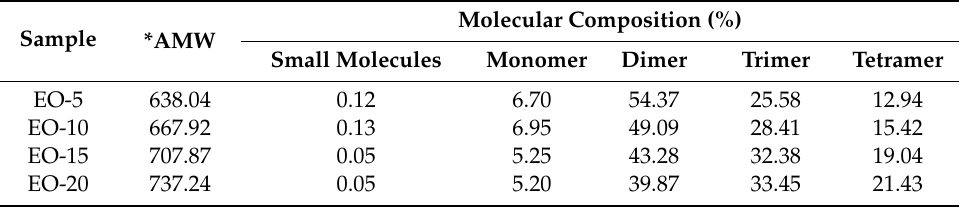
Table 2. The average molecular weight and molecular compositions of isotropic pitch precursors. Sample